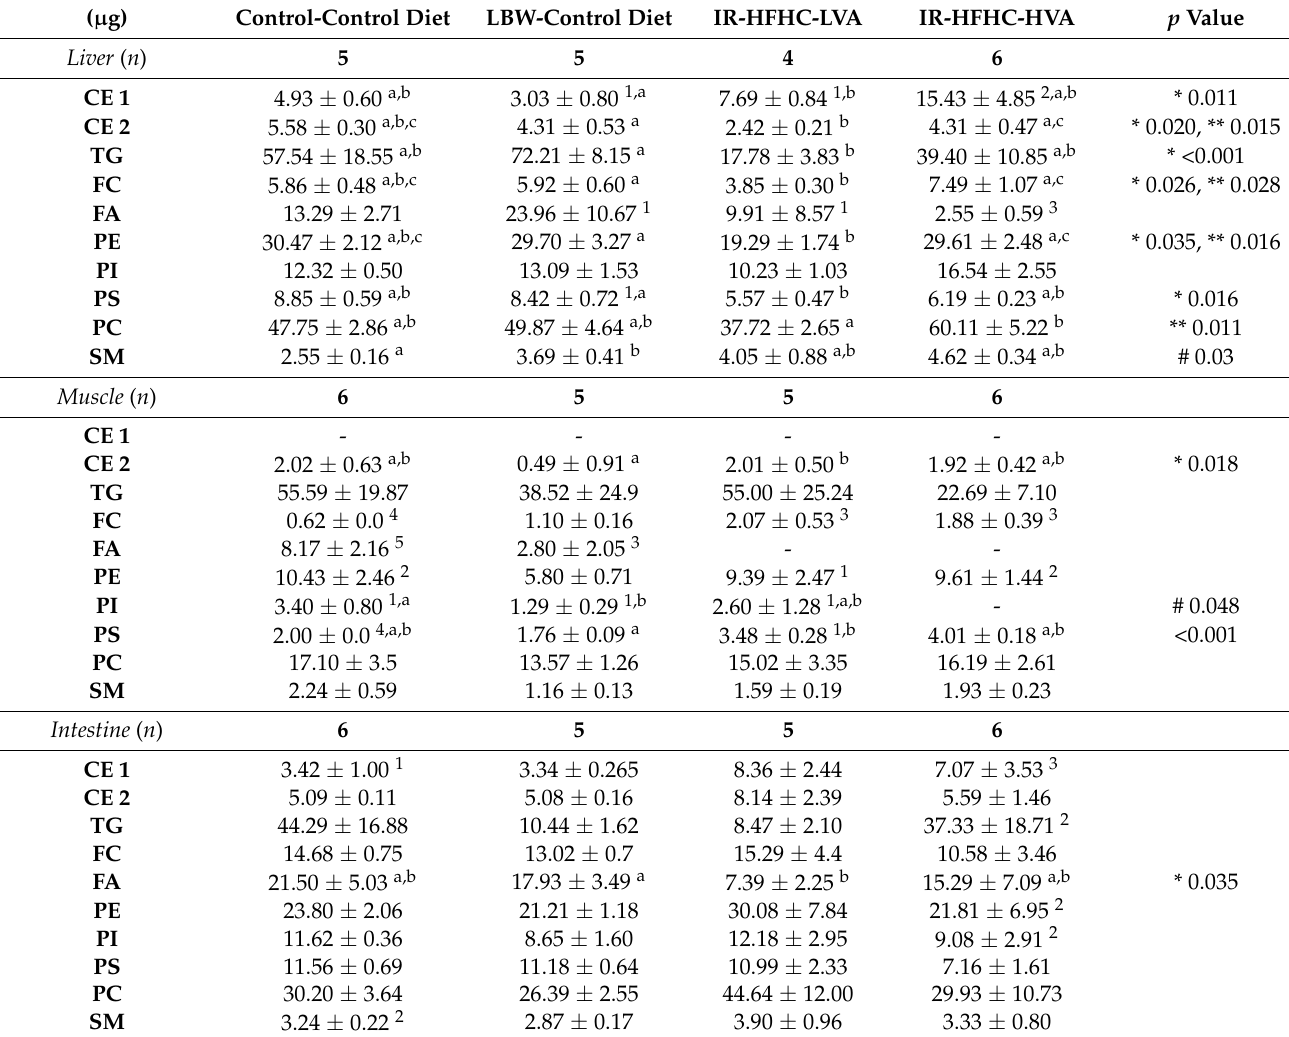
Table 6. Lipid profiles of liver, muscle and intestinal tissue samples of control and LBW pigs fed control, HFHC-LVA, and HFHC-HVA